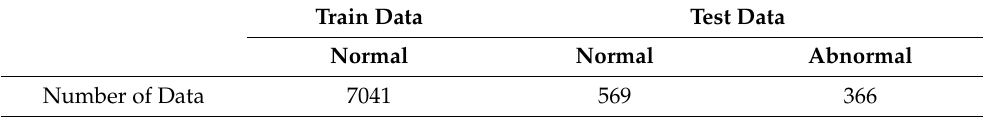
Table 1. Configuration of total data set.